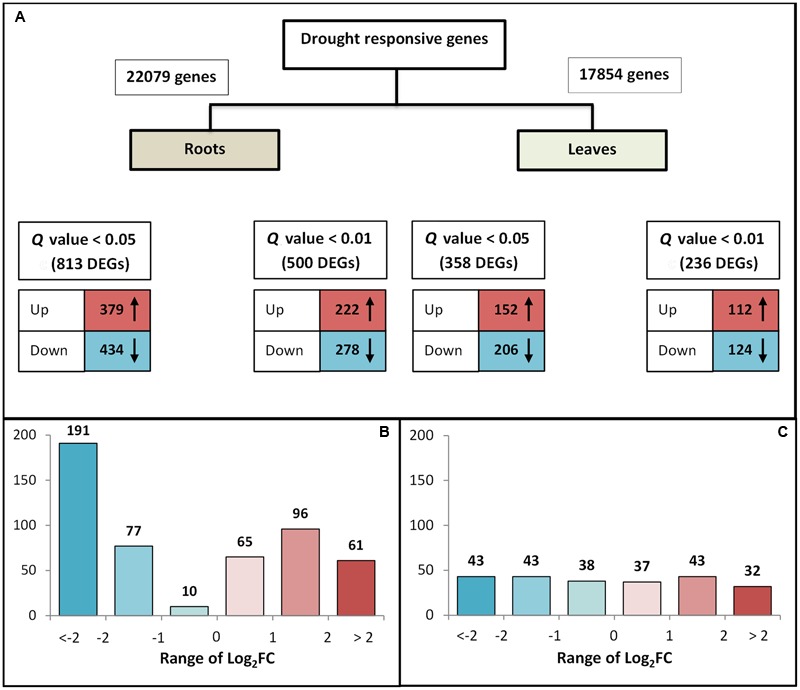
(A) Number of total and differentially expressed genes (DEGs) showing either upregulation or downregulation at different Q-values in roots (GF677 rootstock) and leaves (graft, var. Catherina). Up: upregulated genes (red); down: downregulated genes (blue). (B,C) Relative expression of DEGs selected at Q-value < 0.01 in roots and leaves. The color intensity indicates the level of the change in expression: a darker color represents a larger change in expression. The x-axis indicates the range of Log2FC. The fold change (FC) was calculated as the ratio between the drought-stressed and control plants, while the y-axis indicates the number of detected DEGs.